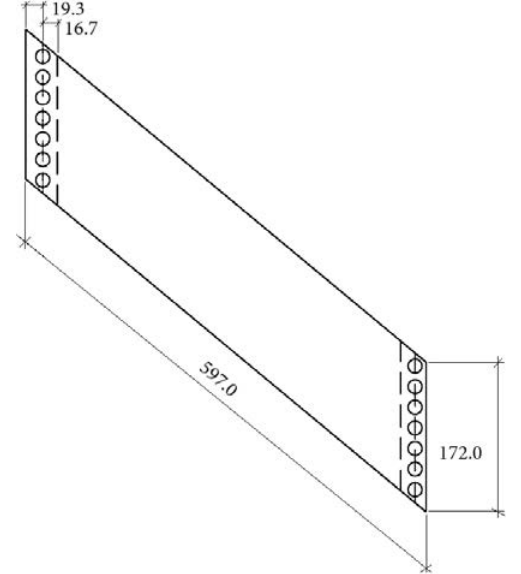
Fig. 2. Plan view of the skewed integral bridge (skew angle 56° against center line of the flood channel) (in mm)